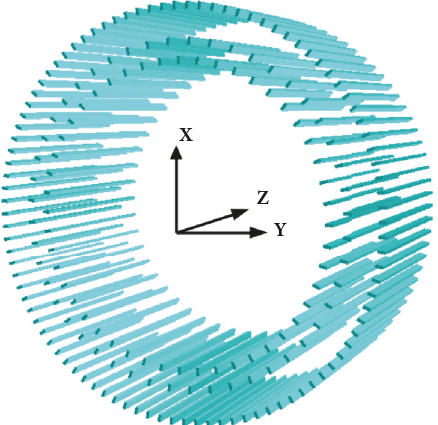
Figure 1: Schematic view of the J-PET detector consisting of 192 plastic scintillator strips arranged in three concentric layers with radii ranging from 42.5 cm to 57.5cm. The strips are oriented along the Z axis of the detector barrel.